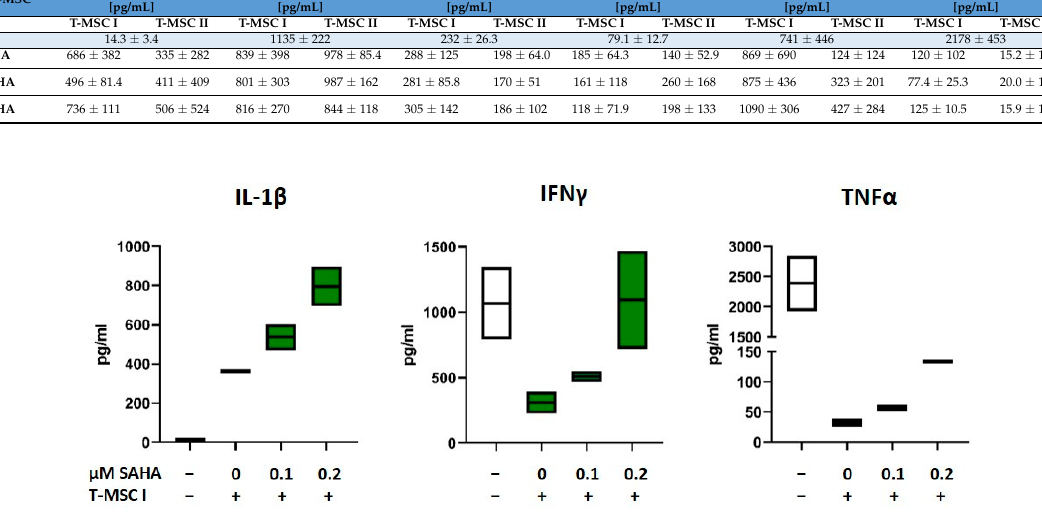
Figure 6. Production of IL-1 β , IFN γ , and TNF α after co-cultivation with SAHA-treated T-MSC. PBMC were stimulated with IL-2/OKT3 and co-cultivated without (-), with control-treated T-MSC or previously SAHA-treated T-MSC. Supernatants of co-cultures were analyzed after 48 h. The cytokine levels were determined by Multiplex analyses. PBMCs of two different healthy donors were co-cultivated with T-MSC of two different origins in four separate experiments. Boxplots show distribution and mean of one example experiment for each cytokine, n = 2. T-MSC: tumor-derived mesenchymal stromal cell; IL: interleukin; IFN γ : interferon-gamma; TNF α : tumor necrosis factor alpha; SAHA: suberoylanilide hydroxamic acid.